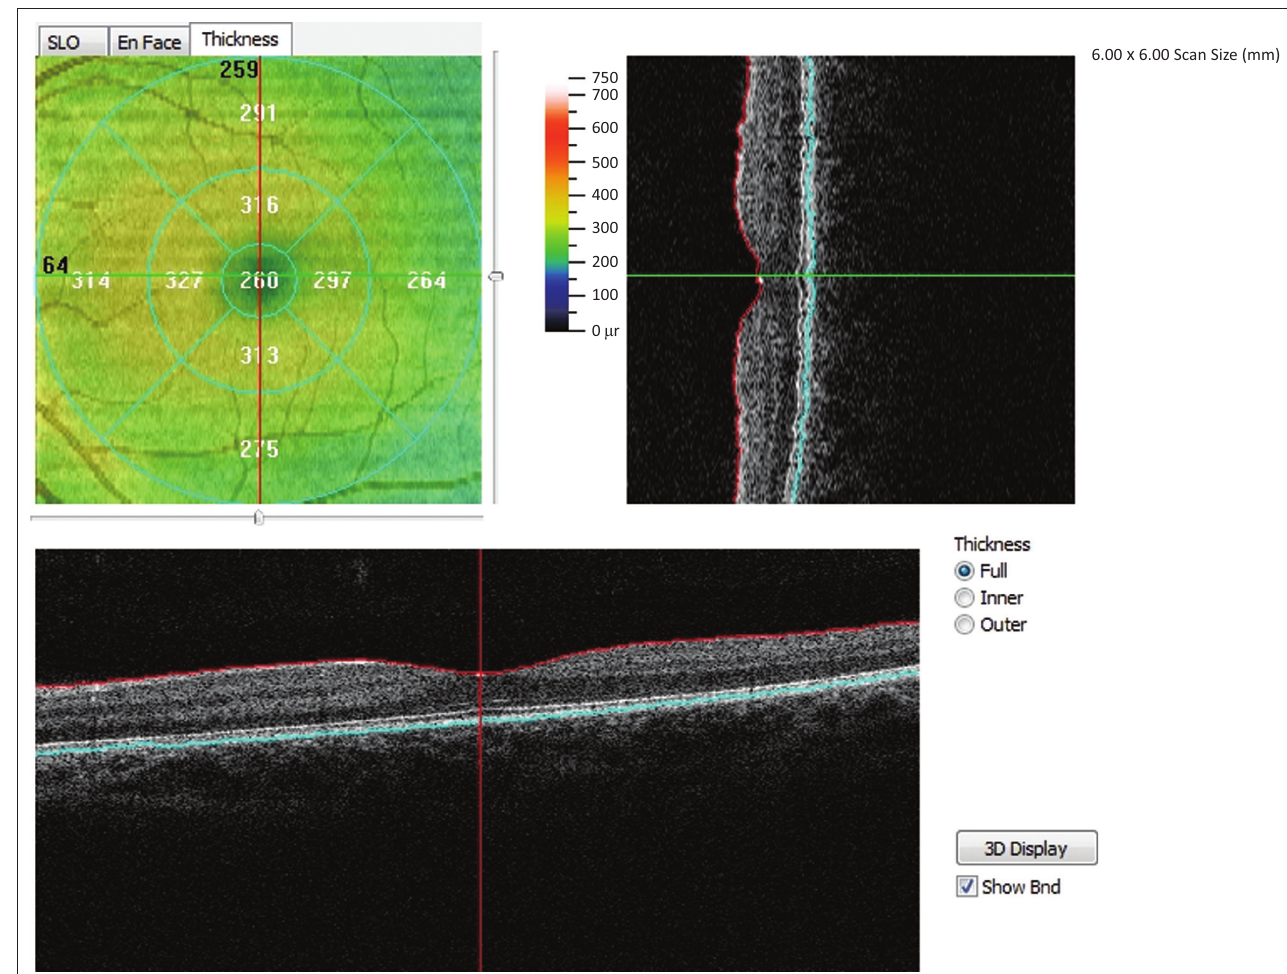
The top left picture shows the macular map, automatically divided into nine Early Treatment Diabetic Retinopathy Study sectors. FIGURE 1: Example of macular thickness measurements obtained using iVue-100 optical coherence